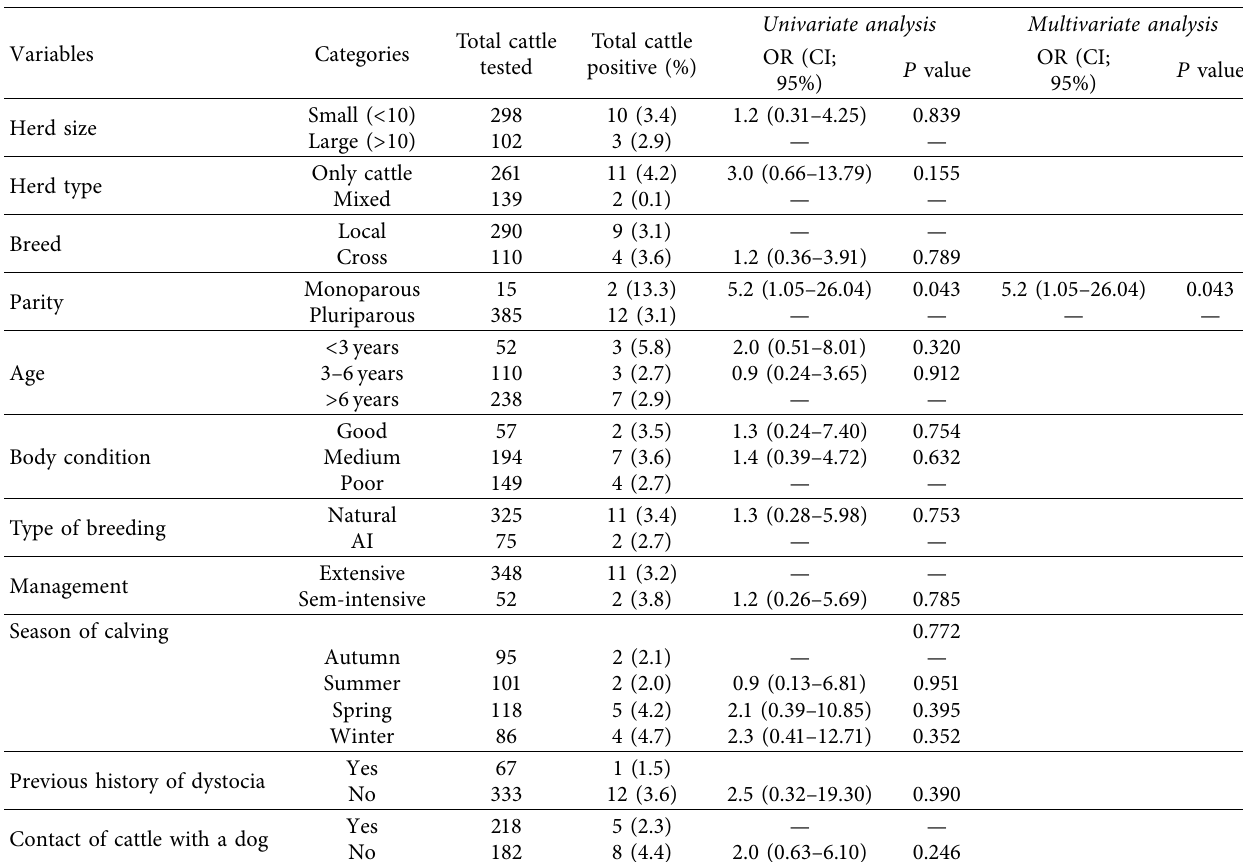
Table 5: Te efect of potential risk factors for cattle dystocia in the study